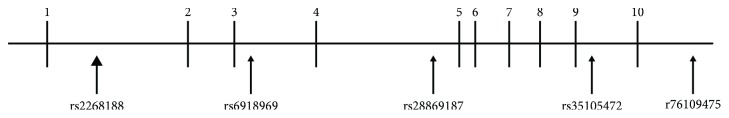
Schematic representation of the NF-YA gene. The relative position of each exon is marked by vertical lines; the arrow indicates the relative location of SNPs genotyped in the current study.